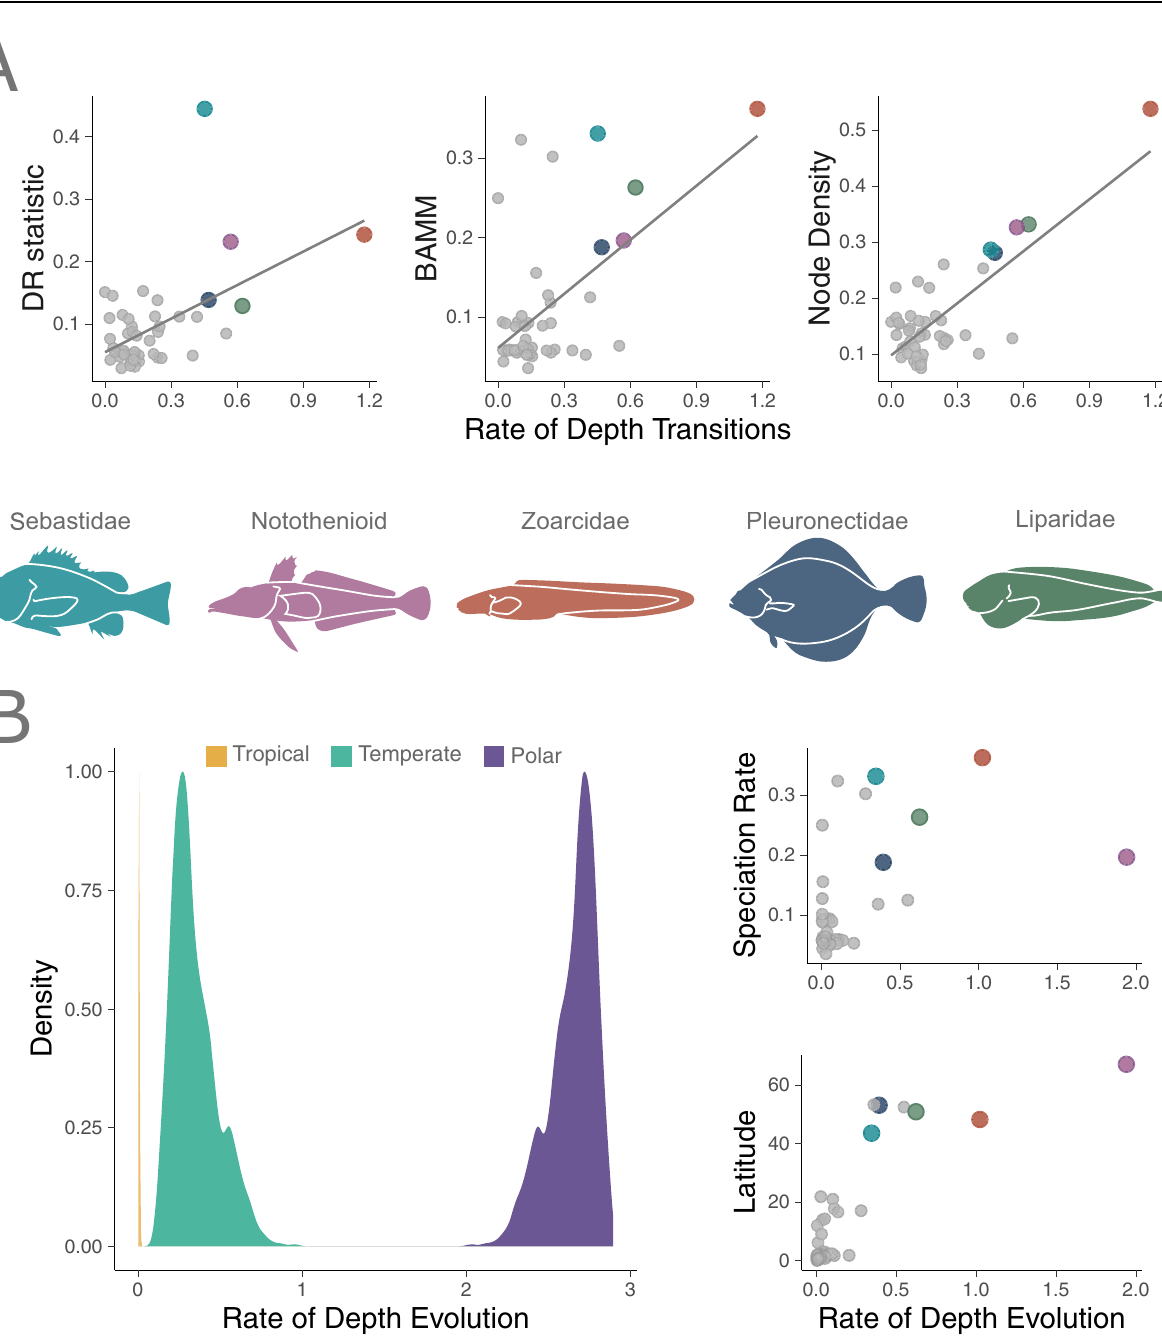
distributions of rates by latitude and the clade-wise relationship between MuSS- CRatdepthrates,speciation(BAMM),andlatitudebyclade( B ).Thereissubstantial support for independent rates of evolution associated with different latitudes. Source data are provided as a Source Data fi